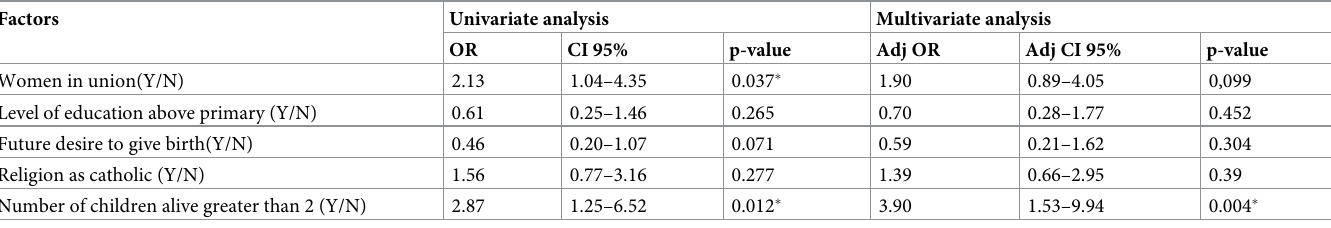
Table 3. Determinants of long acting reversible contraceptive